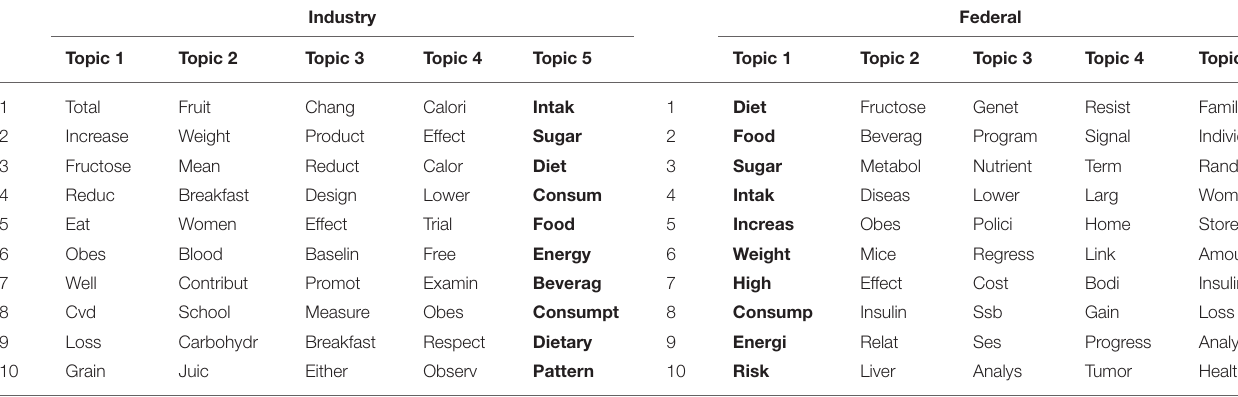
TABLE 3 | Topic models for industry and federally-funded research reports on sugar in the human diet.